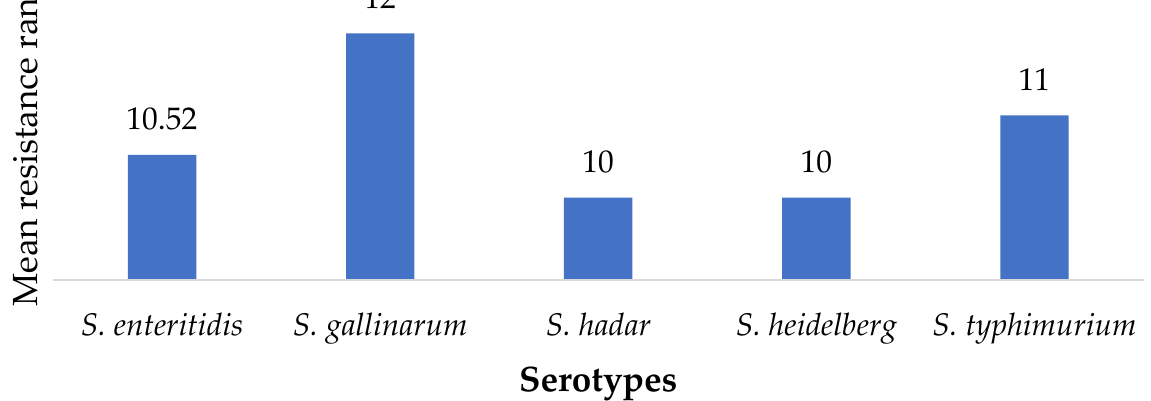
Table 2. Susceptibility profile of isolates to antimicrobials.